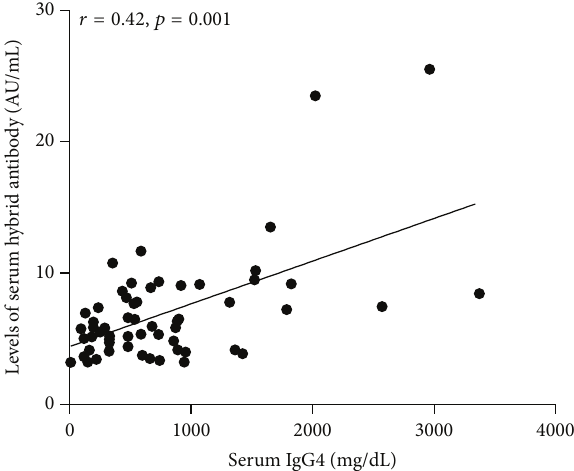
Figure 6: The relationship between serum levels of 𝜅 / 𝜆 hybrid antibody and serum IgG4 in patients with RA. Serum IgG4 (mg/dL) wasmeasuredin58RApatientsusingimmunonephelometry.Levels of serum 𝜅 / 𝜆 hybrid antibody showed significant correlation with serum IgG4 ( 𝑟 = 0.43 , 𝑝 = 0.001 ). Concentrations of 𝜅 / 𝜆 hybrid antibody are presented in arbitrary units (AU/mL). Sym- bols represent individual subjects. Correlations were determined by Spearman’s rank correlation coefficients with 95% confidence